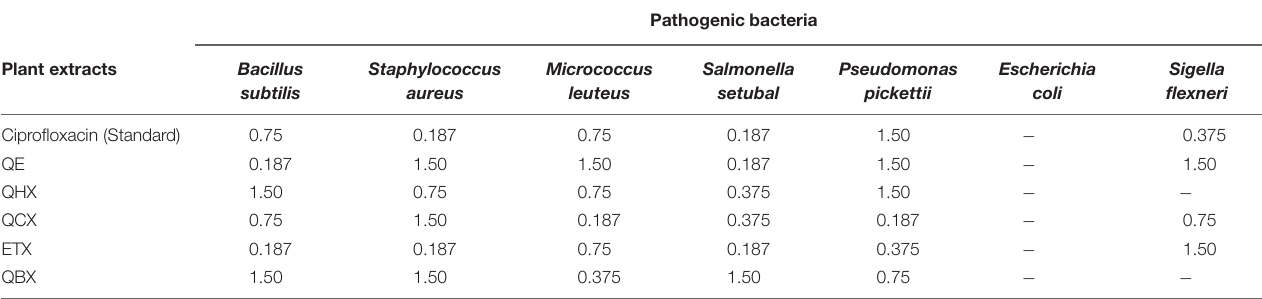
TABLE 4 | Minimum inhibitory concentration (MIC) values of Q. incana Roxb. measured at different concentrations (mg/ml).